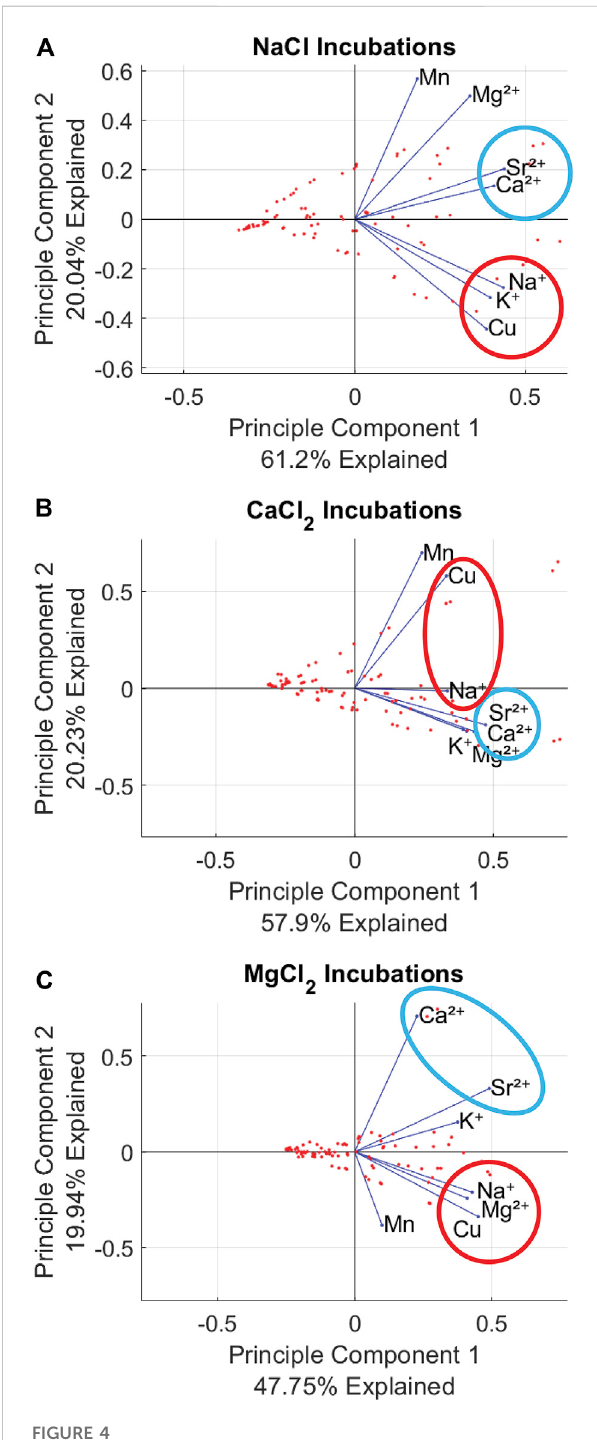
FIGURE 4 PCA plots showing chemical cocktails mobilized by different salts. All results indicate chemical cocktail dispersion with 6 of the 7elementsanalyzedbeingcorrelatedwiththeNa,Ca 2+ ,orMg 2+ added during incubations. Panel (A) shows NaCl incubation results, which illustrate Sr-Ca and Cu-Na co-mobility. Panel (B) shows CaCl